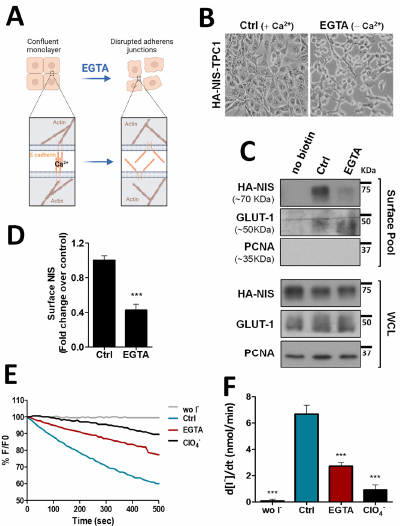
Figure 1. Impact of adherens junction integrity on HA-NIS abundance and function at the PM. ( A ) Representative diagram of AJs disruption by EGTA, a chelator with specificity for calcium ions, that destabilizes AJs by removing calcium from interacting cadherins in adjacent cells. AJ dissociation leads to the disaggregation of the catenin-mediated complex that anchors the AJ to actin. The figure was created with BioRender.com, accessed on 26 July 2022. ( B ) Representative images of AJs disruption of HA-NIS-TPC1 cells treated for 30 min with either CaCl 2 (1 mM)-containing PBS (Ctrl) or calcium-free PBS containing 4 mM of EGTA. ( C ) HA-NIS PM abundance was assessed in cells treated as in ( B ) by surface protein biotinylation. Surface fraction or the correspondent whole-cell lysates (WCL) were analyzed by WB using an anti-HA antibody to detect the HA-NIS protein. A replica where cells treated as in ‘Ctrl’ were not incubated with biotin (no Biotin) controlled the specificity of biotinylated protein pull-down. GLUT-1 served as loading control (for densitometric normalization) among cell-surface protein extracts and WCL, whereas PCNA monitored for both WCL loading and eventual intracellular protein contamination in cell-surface extracts. ( D ) Surface HA-NIS abundance was quantified by densitometry analysis of WB bands, using ImageJ software. Plotted values are means ± SEM of three independent assays. Comparisons to each corresponding control condition were made using a two-tailed Student’s t -test (*** p ≤ 0.001). ( E ) HA-NIS-TPC1 cells stably expressing the YFP halide sensor (HS-YFP) were used to analyze the HA-NIS protein function. The decay of the YFP fluorescence in cells treated as in ( B ) was monitored continuously for 500 s, acquiring an image every 10 s, after exposing the cells to 50 mM NaI. The presence of a competitive inhibitor of iodide uptake by NIS (ClO 4 − -; 50 mM for 10 min) slows or prevents the decay of YFP fluorescence over time, confirming assay specificity. ( F ) Iodide influx rates were derived from the decay curves. Data are means ± SEM of three independent assays. Significances were assessed by one-way ANOVA (F = 49.63; p < 0.001) followed by Dunnett’s tests, compared to control conditions (Ctrl) (*** p < 0.001). The uncropped bolts are shown in Supplementary Materials File